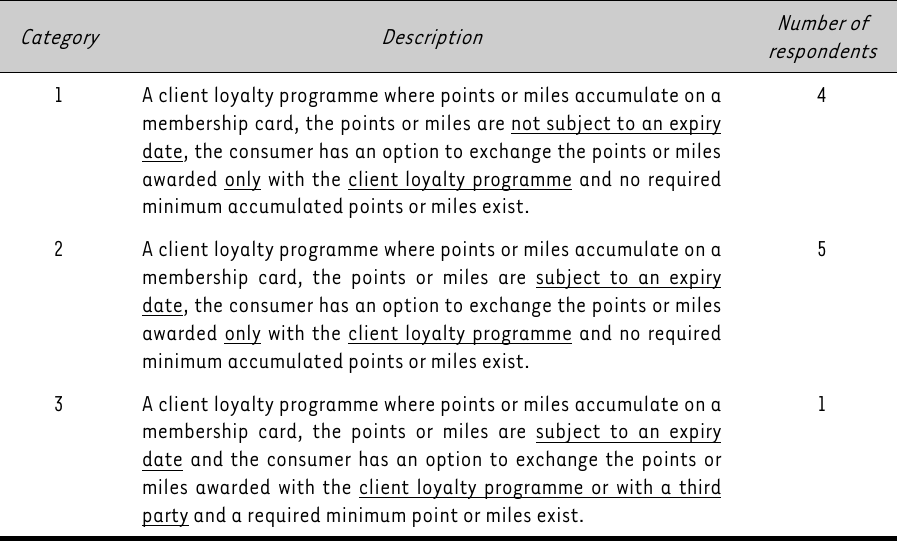
Description of client loyalty programme and corresponding number of respondents Category Description